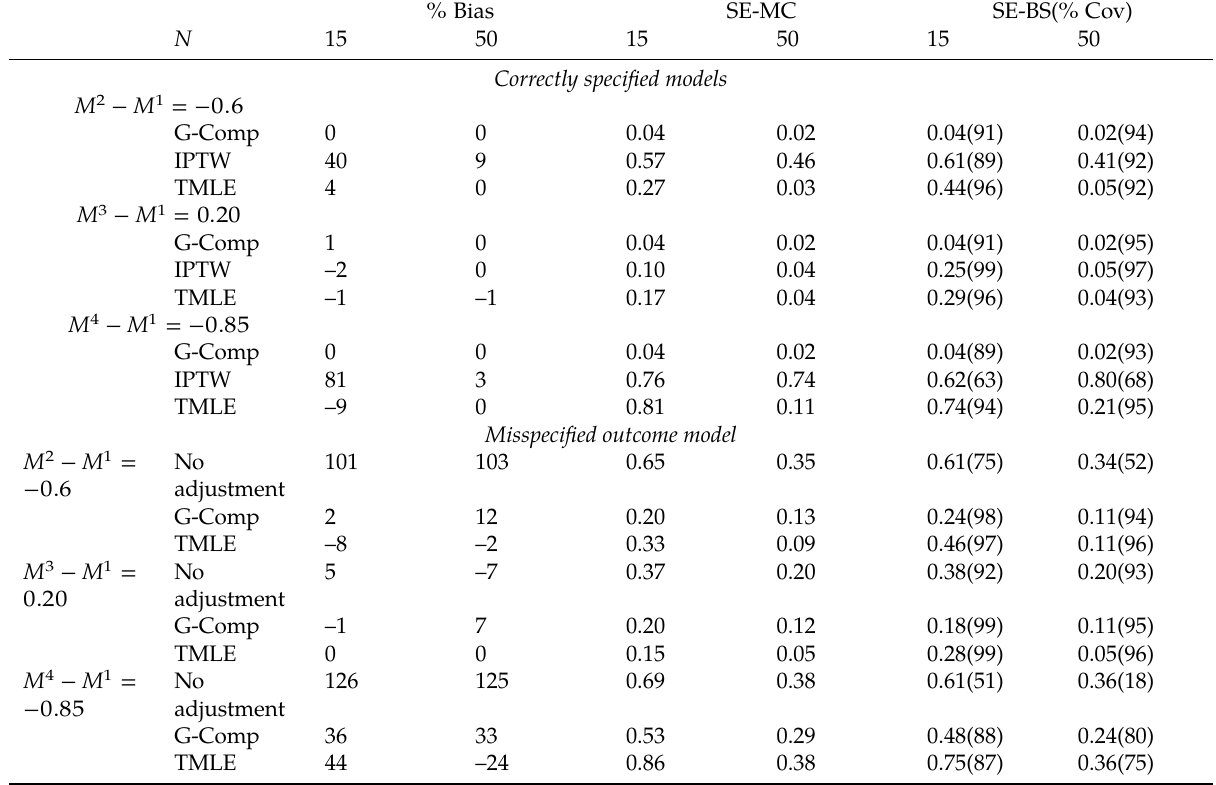
Table 2: Simulation: quality of treatment contrast estimation with a Gaussian outcome (two-arm studies, 1,000 simulated